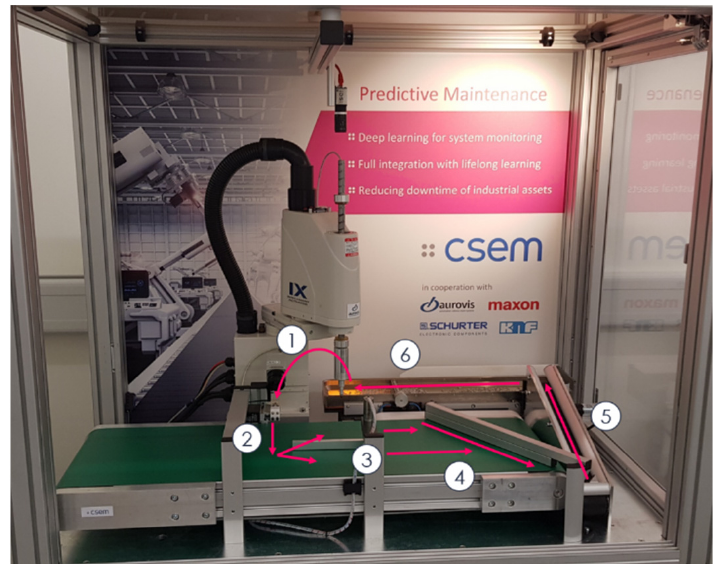
Figure 1. Equipment: 4-axis SCARA-robot picking up electrical fuses with a vacuum gripper, from a feeder to a fuse-test-bench for a large-scale quality-control. Arrows represent the main phases involved in the quality-control process: (1) picking up, (2) thermal camera control, (3) sorting, (4), (5) transport and (6)